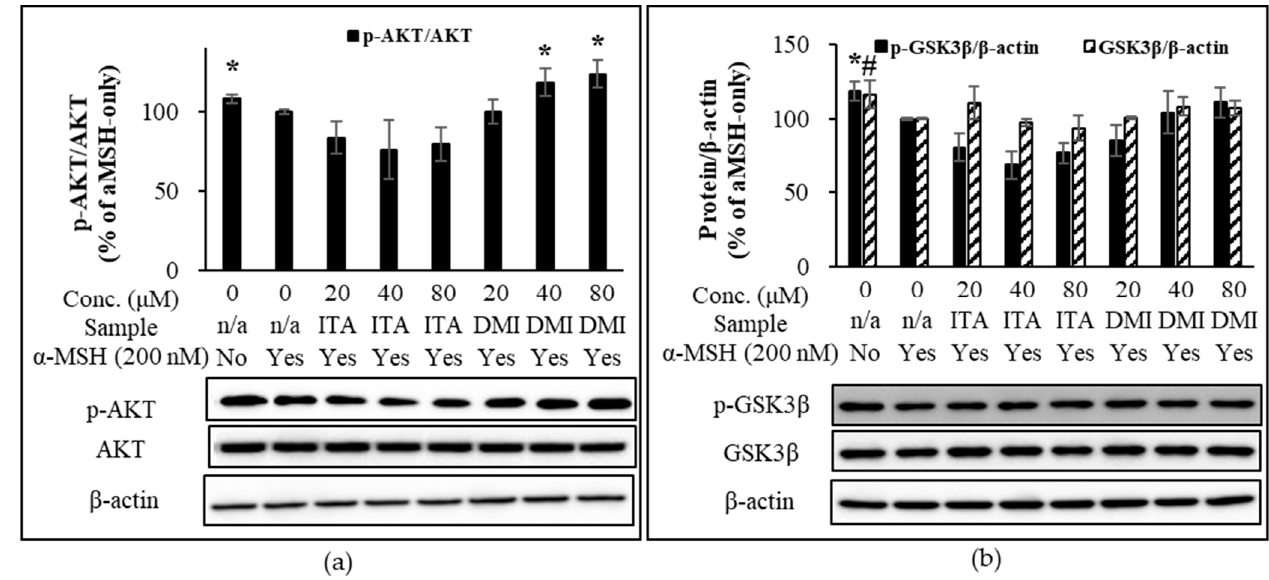
Figure 6. Effect of ITA and DMI on the α -MSH-induced phosphorylation of AKT and GSK3 β . The expression level of p-AKT was normalized to that of total AKT while the expression level of p-GSK3 β , GSK3 β , and MITF was normalized to those of β -actin. The relative expression level was compared to that of α -MSH only. ( a ) Effect of ITA and DMI on the α -MSH-induced phosphorylation of AKT. ( b ) Effect of ITA and DMI on the α -MSH-induced expression of p-GSK3 β and GSK3 β at 15 min post- α -MSH treatment. The data were presented as the mean ± standard deviation of three independent experiments; * p < 0.05, # p < 0.05 compared with α -MSH only.